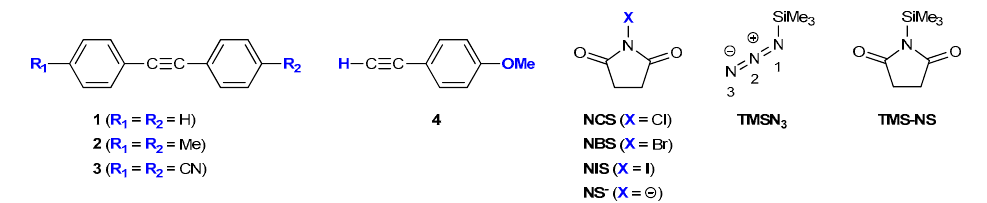
Figure 1. Chemical structures of investigated systems.